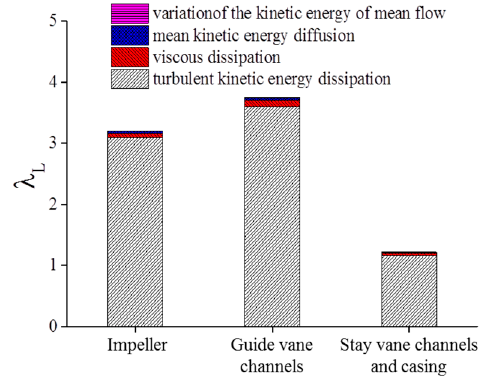
Figure 22. Composition of the loss coefficient at condition V.